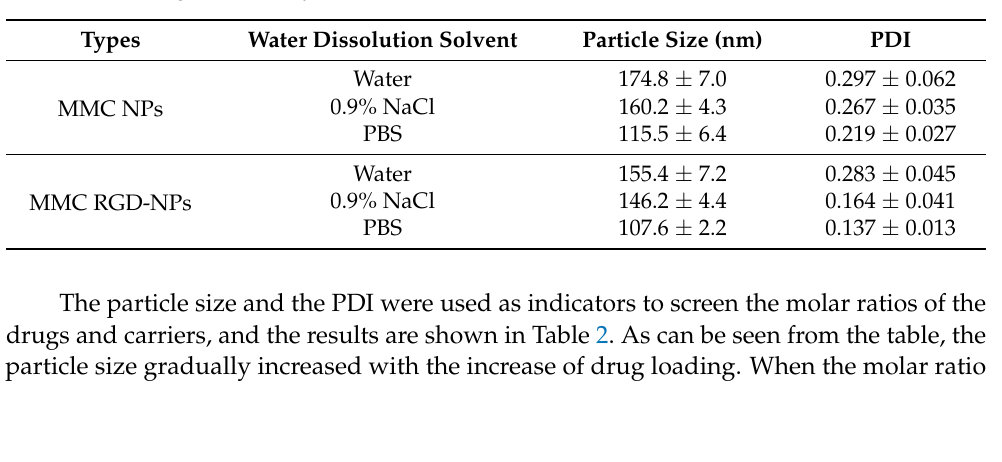
Figure 2. Determination results of Fmoc-Lys-PEG and Fmoc-Lys-PEG-RGD. ( A ) MALDI-TOF-MS spectra of Fmoc-Lys-PEG. ( B ) MALDI-TOF-MS spectra of Fmoc-Lys-PEG-RGD. Table 1. Screening results of hydration